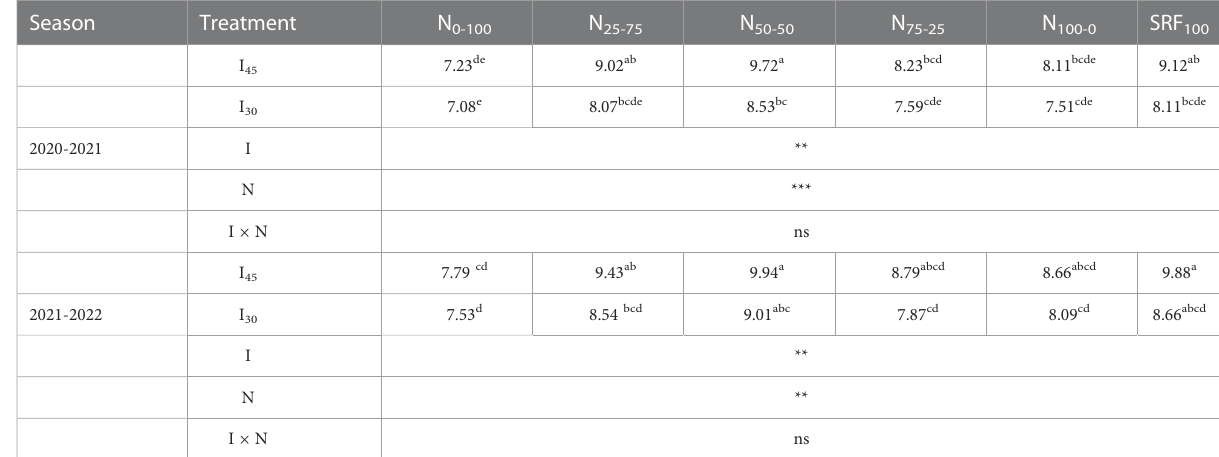
TABLE 3 In fl uence of different irrigation scheduling and nitrogen application modes on winter wheat grain yield (t ha − 1 ) during 2020-2021 and 2021-2022 growing seasons. Season